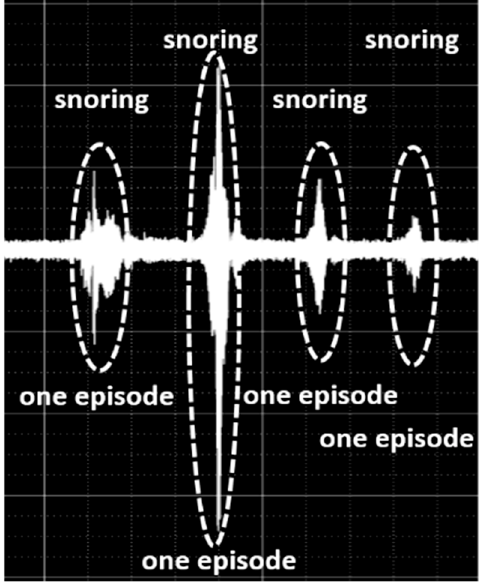
Figure 1. Enumerating sound waveforms of 10,078 snore episodes.